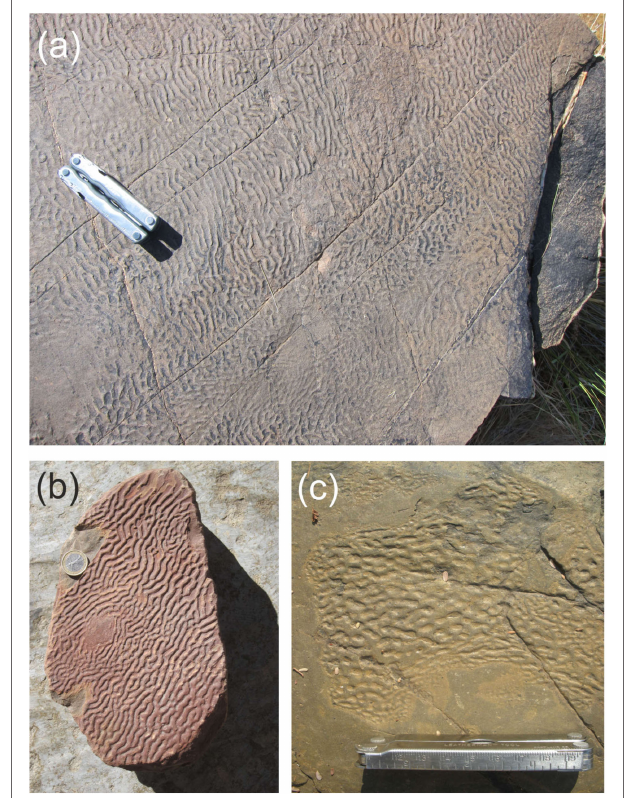
FIGURE 1 | Proterozoic Kinneyia structures from Neuras and Haruchas farms, Namibia . While the Neuras facies (A,B) displays large ( > 1m 2 ) areas covered with clearly oriented ripples, the Haruchas facies (C) is rather characterized by small ( (cid:25) 10cm across) patches of honeycomb-like